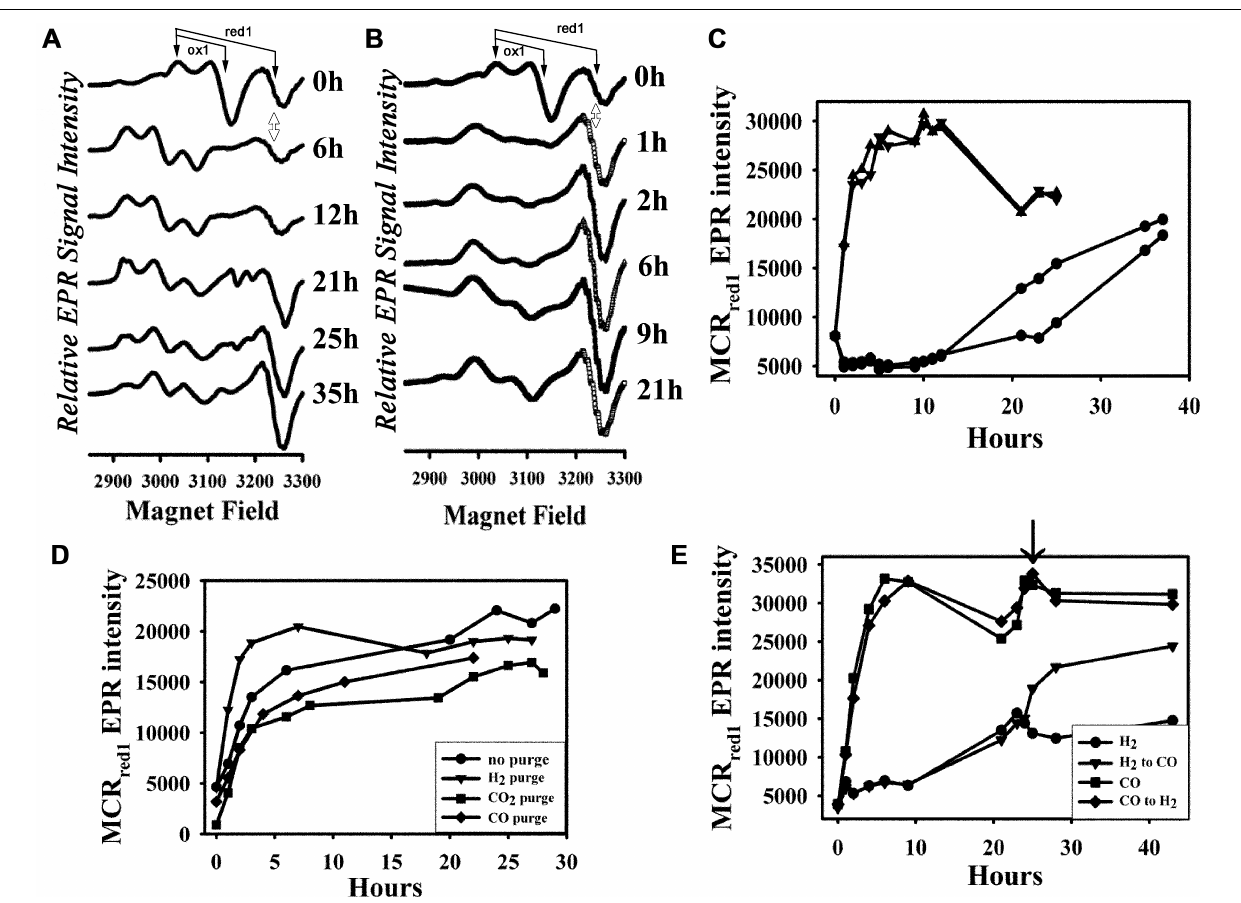
FIGURE 1 |Activation of MCR by H 2 and CO in vivo . (A) EPR spectra of the H 2 -activated cell samples at different time points; (B) EPR spectra of the CO-activated cell samples at different time points; (C) plot of intensity of the MCR red1 EPR signal (the “S”-shaped derivative signal at ∼ 3250 G, double-sided arrow) over time with duplicate H 2 - (circles) and CO-(triangles) activated cell samples; (D) plot of MCR red1 EPR intensity over time with CO